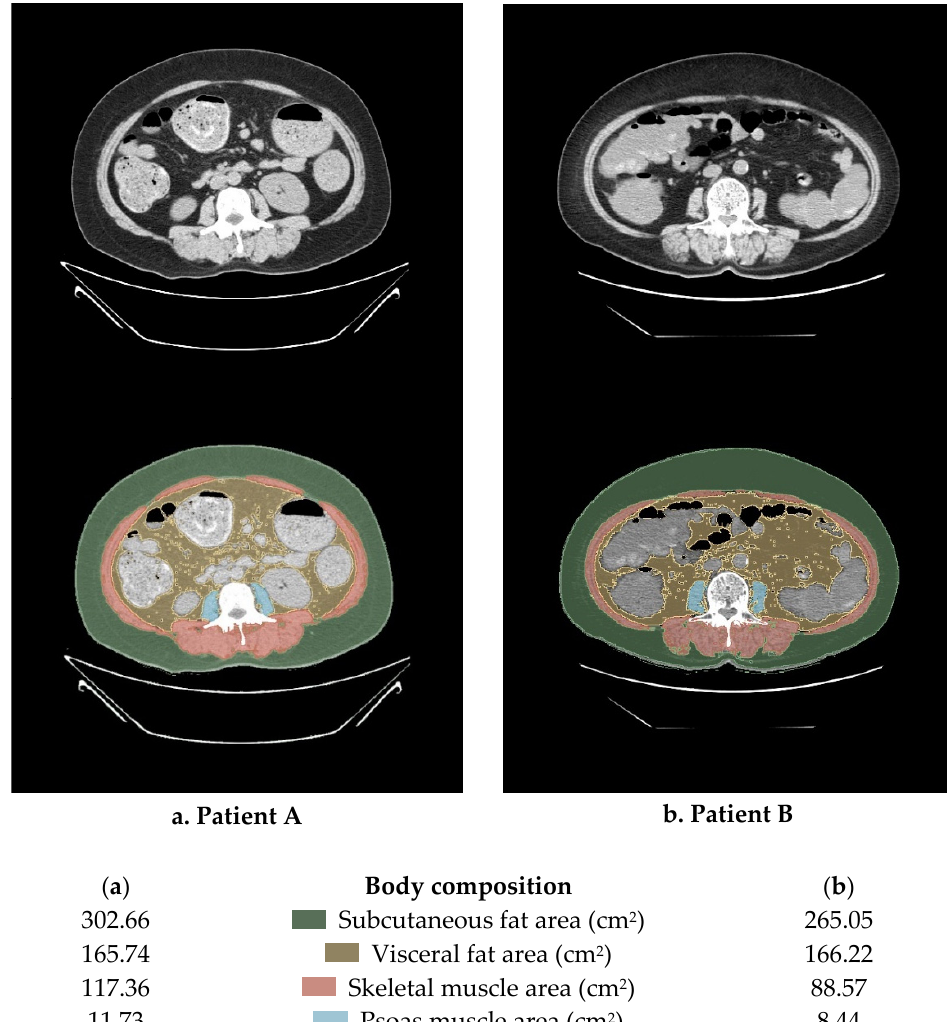
Figure 1. An example of the method for calculating body composition using abdominopelvic computed tomography (APCT). This image is a cut of the L3 and the body mass index of the two patients is the same at 30 kg/m 2 . Table 2. Comparison of nutrition, inflammatory index, and body composition according to